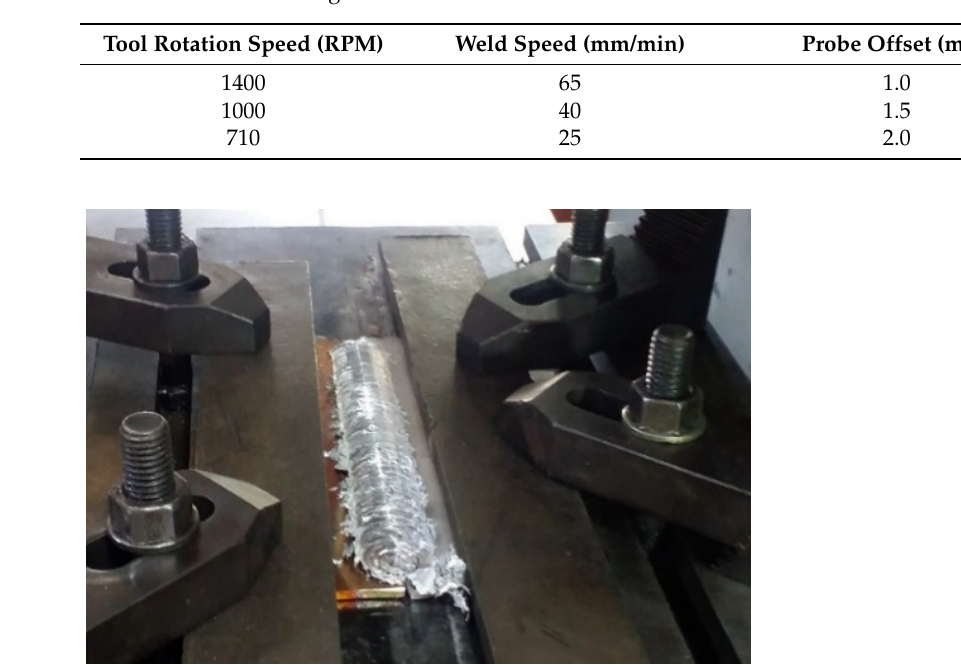
Figure 5. Pictorial view of the FSW joint after the welding process.